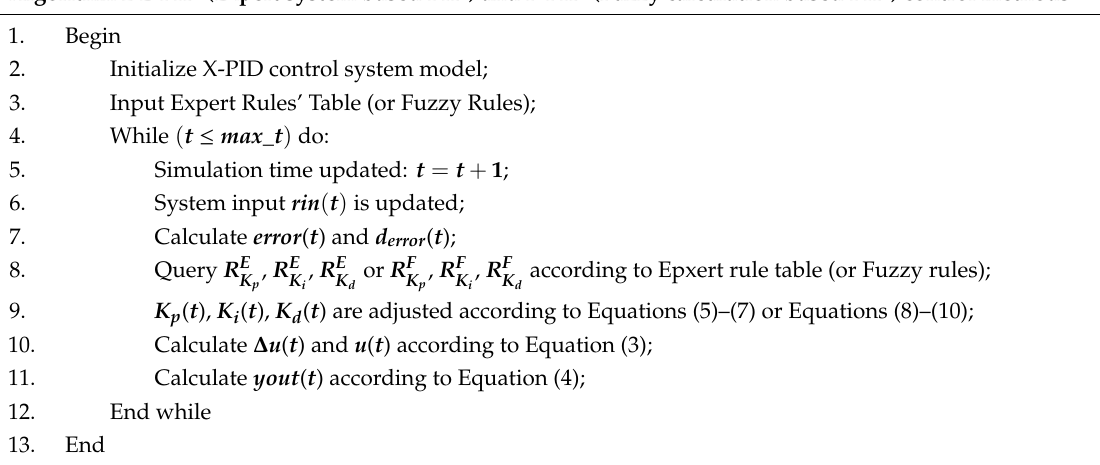
Algorithm 2 E-PID (Expert system based PID) and F-PID (Fuzzy calculation based PID) control